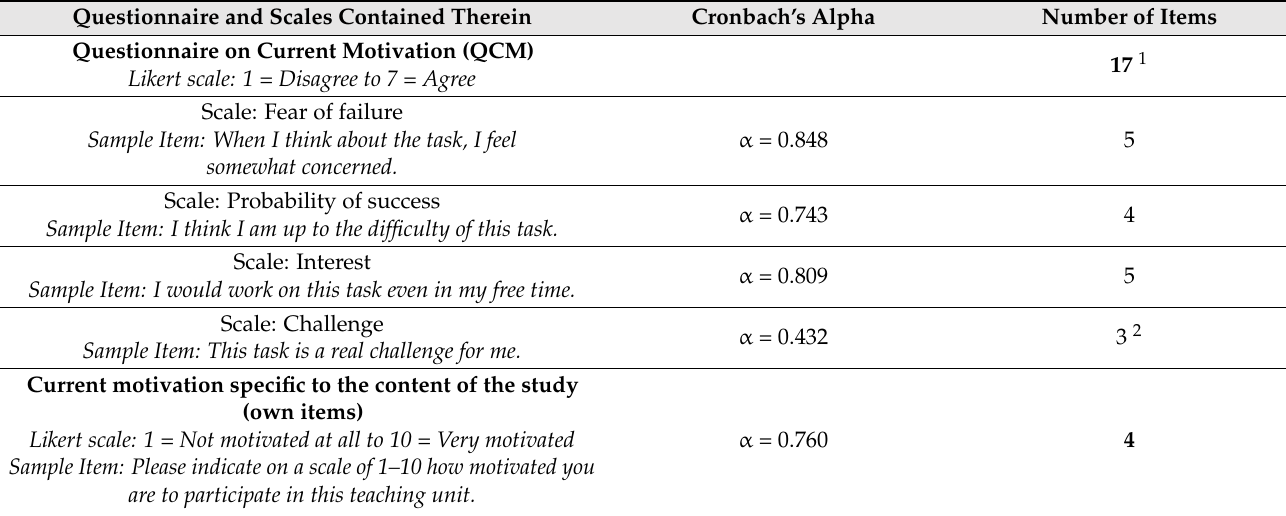
Table 1. Overview of the questionnaires and scales used in the paper-based survey.